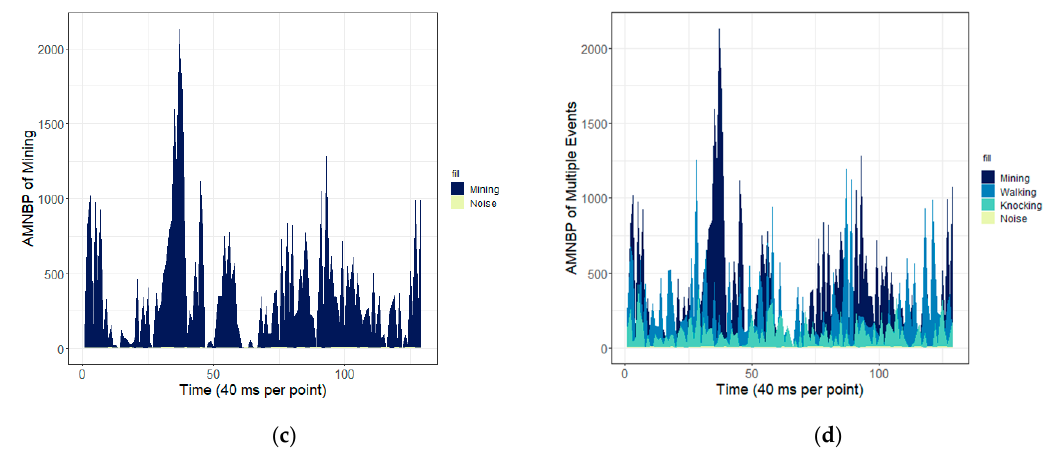
Figure 10. The contrast AMNBP results of four types of signals: ( a ) Knocking and noise, ( b ) Walking and Noise, ( c ) Manual mining and noise, and ( d ) Four types of signals.